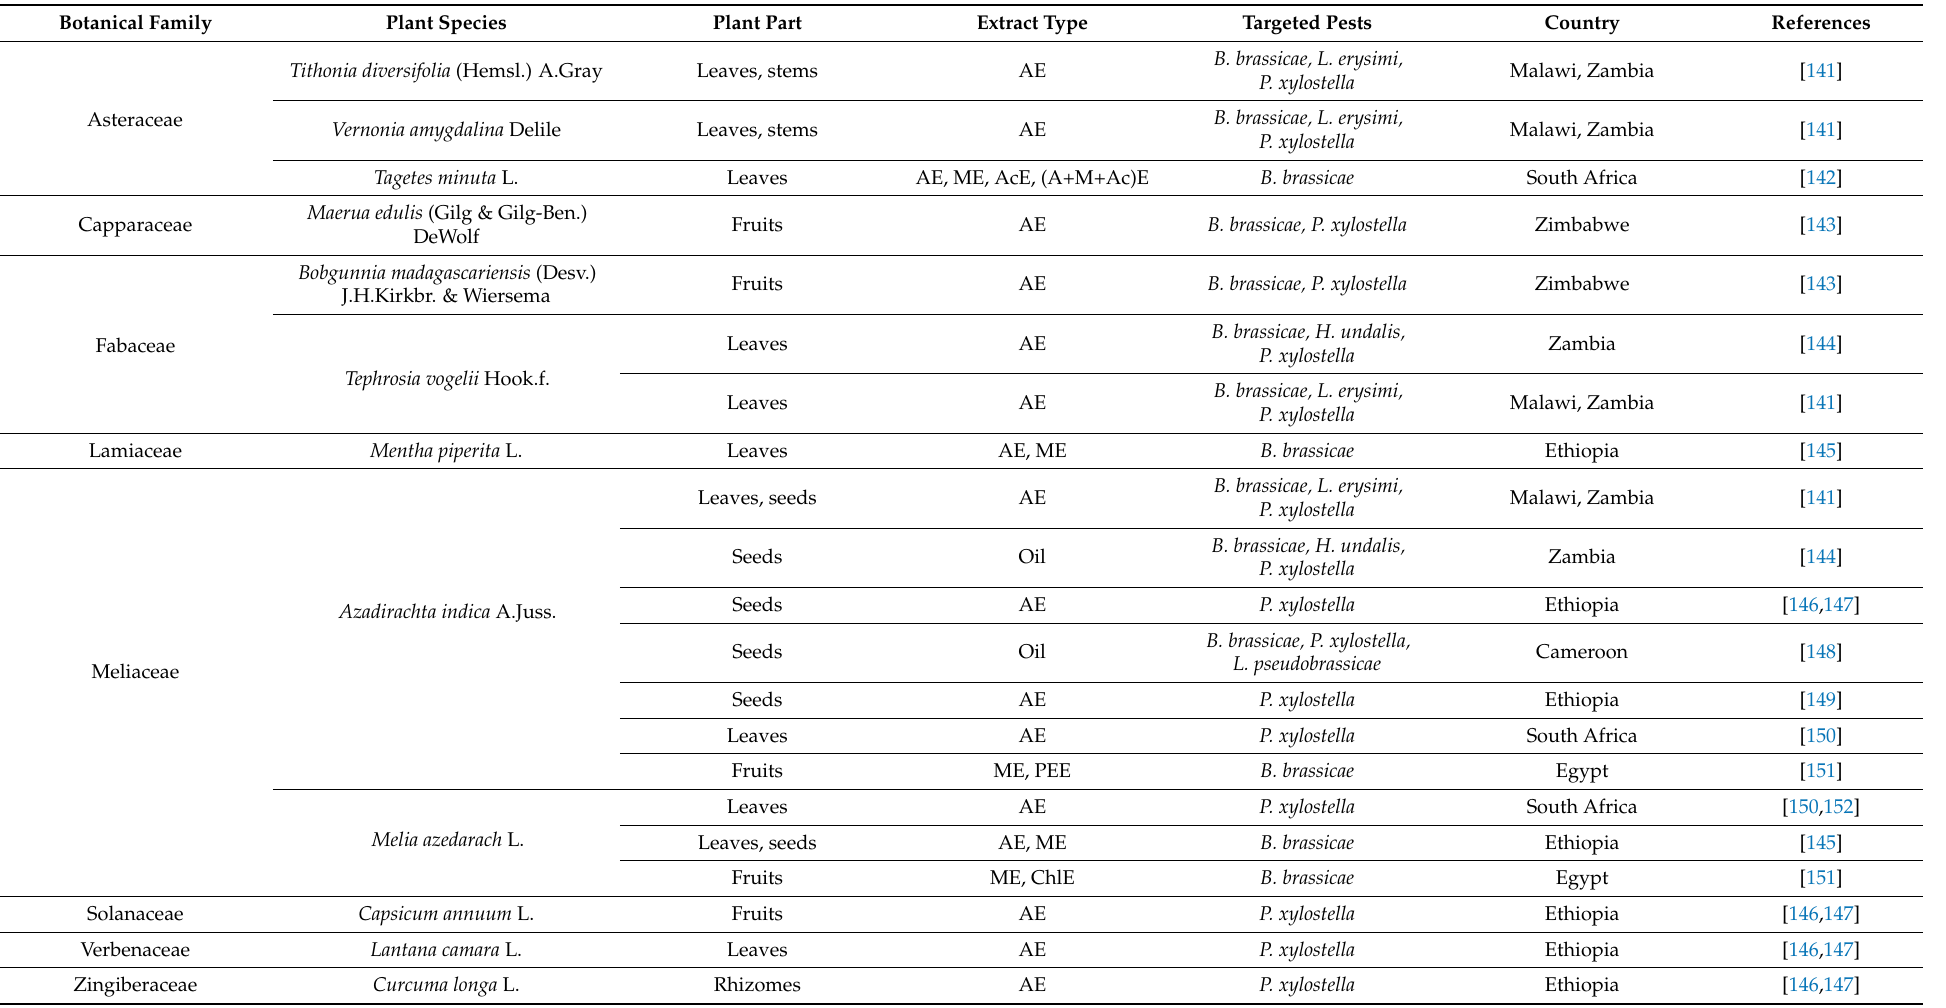
Table 4. Plant species tested or currently used for managing P. xylostella , H. undalis and aphids ( L. erysimi or B. brassicae ) in Africa outside West Africa. Botanical